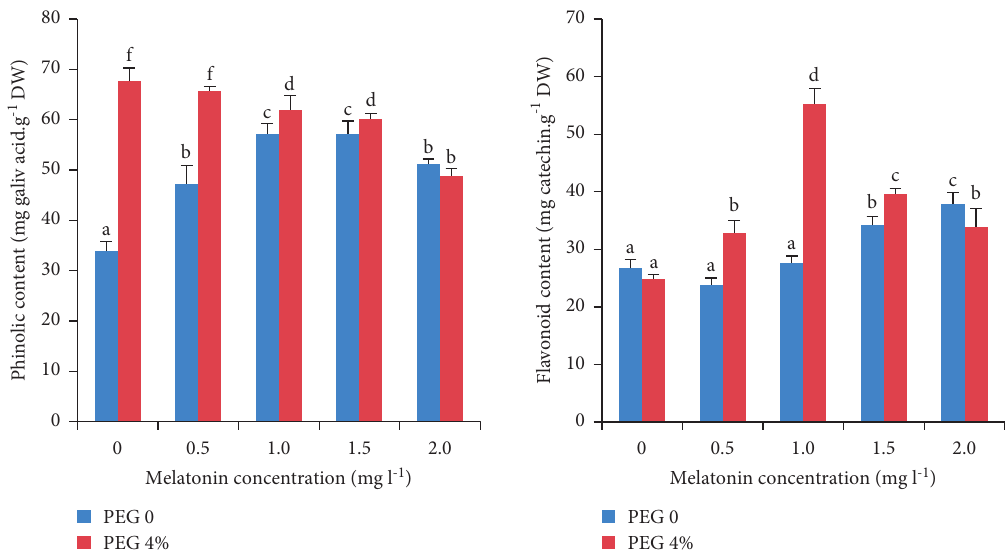
Figure 4: PC and FC activity in H. pusillus calli cultures treated with melatonin concentrations and PEG levels after 28 days. Vertical bars indicate the standard errors of triplicates. Different alphabets indicate significant statistical differences between the mean values based on Duncan’s test at P ≤